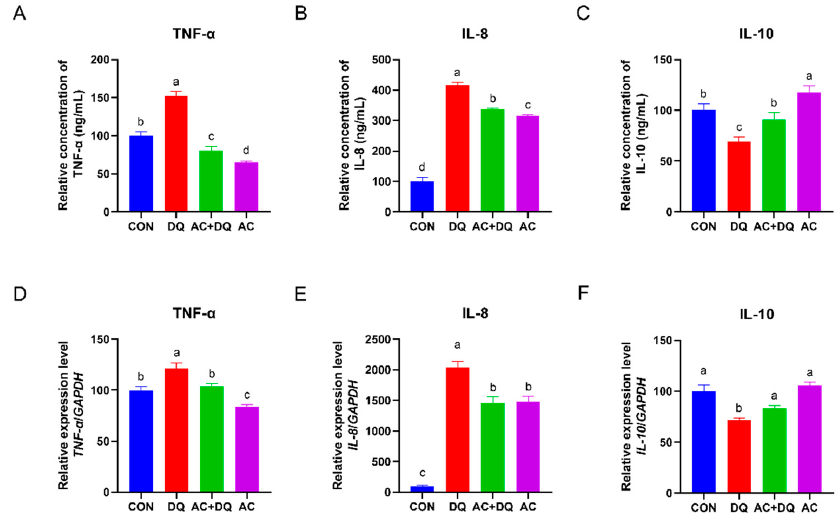
Figure 4. Effects of acidifiers on the secretion and gene expression level of inflammatory cytokines in diquat-challenged IPEC-J2 cells. ( A ) Concentration of TNF- α in the IPEC-J2 cells culture supernatant. ( B ) Concentration of IL-8 in the IPEC-J2 cells culture supernatant. ( C ) Concentration of IL-10 in the IPEC-J2 cells culture supernatant. ( D ) The gene expression level of TNF- α . ( E ) The gene expression level of IL-8 . ( F ) The gene expression level of IL-10 . CON, cells without being treated; DQ, cells were only treated by 1150 µ M of diquat for 6 h; AC + DQ, cells were pretreated by 0.005% acidifier for 4 h and were then treated by 1150 µ M of diquat for 6 h. AC, cells were only treated by 1150 µ M of acidifier for 6 h. All values were represented as means ± SEM ( n = 6). Different superscript letters denote a statistically significant difference between groups ( p < 0.05), while same letters denote no significant